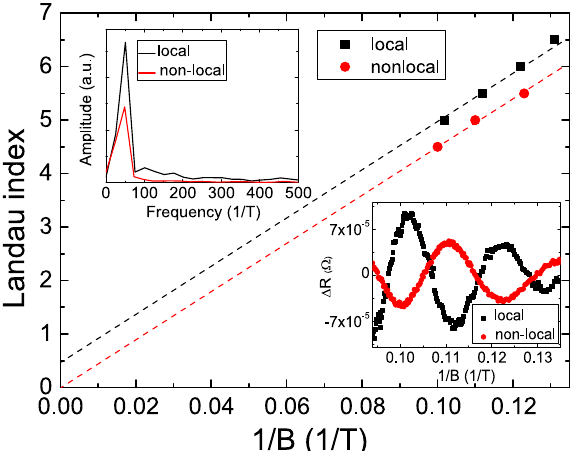
Figure 5. The bottom-right inset shows the extracted SdH oscillations in both configurations. The oscillation shifts a π phase in the two configurations. The top-left inset shows the FFT of SdH oscillation in two configurations. The oscillation peak positions are the same. The Landau level fan diagram of two SdH oscillation. The Berry phase are π in the local configuration and 0 in the nonlocal